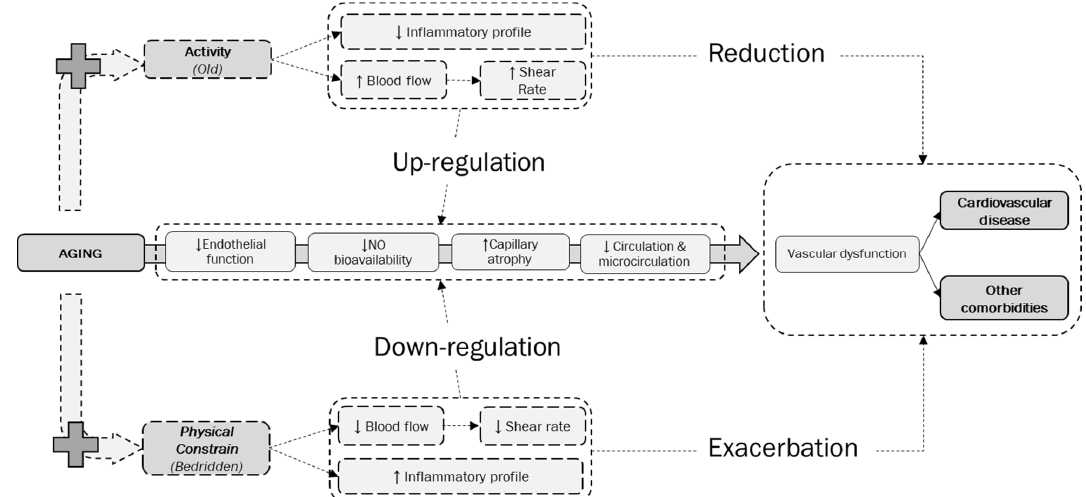
Figure 3. Direct and indirect effects of activity and physical constrain on the physiological aging process. Aging brings with itself several (mal)adaptations at vascular level such as a decrease in endothelial function with a reduction ( ↓ ) of Nitric Oxide (NO) bioavailability, followed by an increase ( ↑ ) in capillary atrophy leading to a poorer circulation and microcirculation. The worsening of these